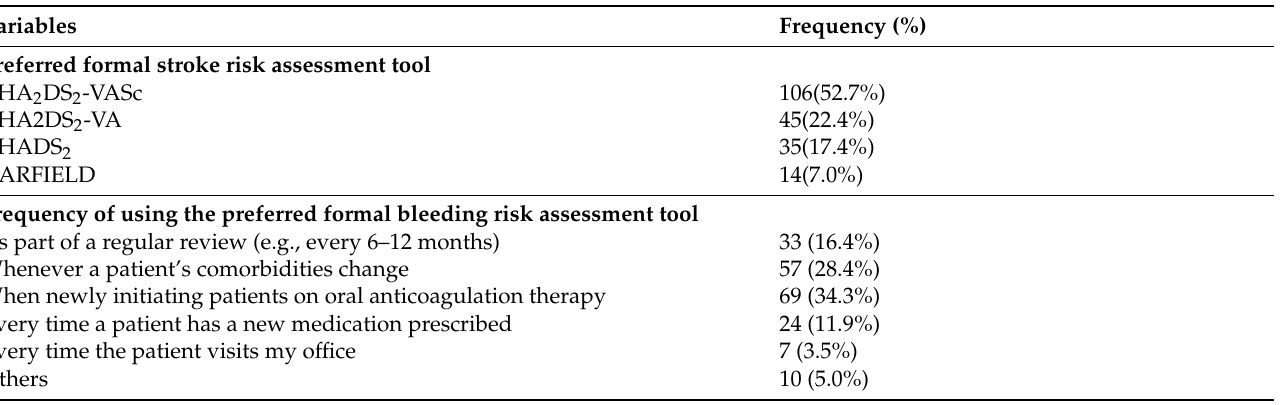
Table 3. Utilization of stroke and bleeding risk assessment tools by GPs (n = 200).